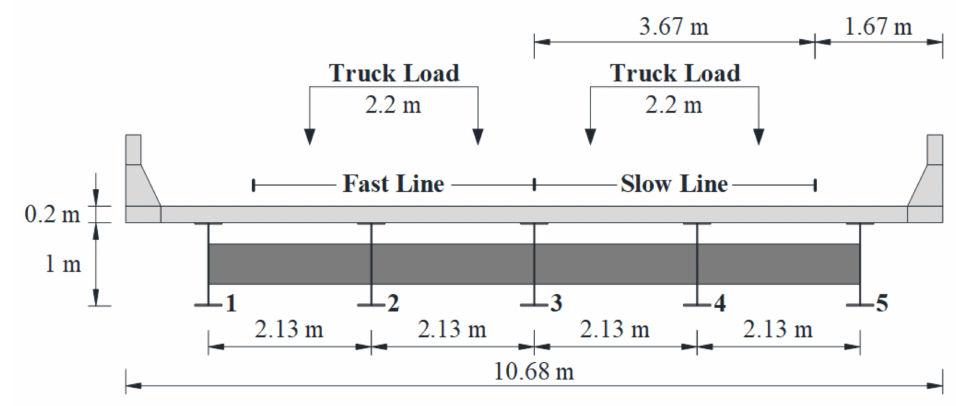
Figure 1. Cross-section of the